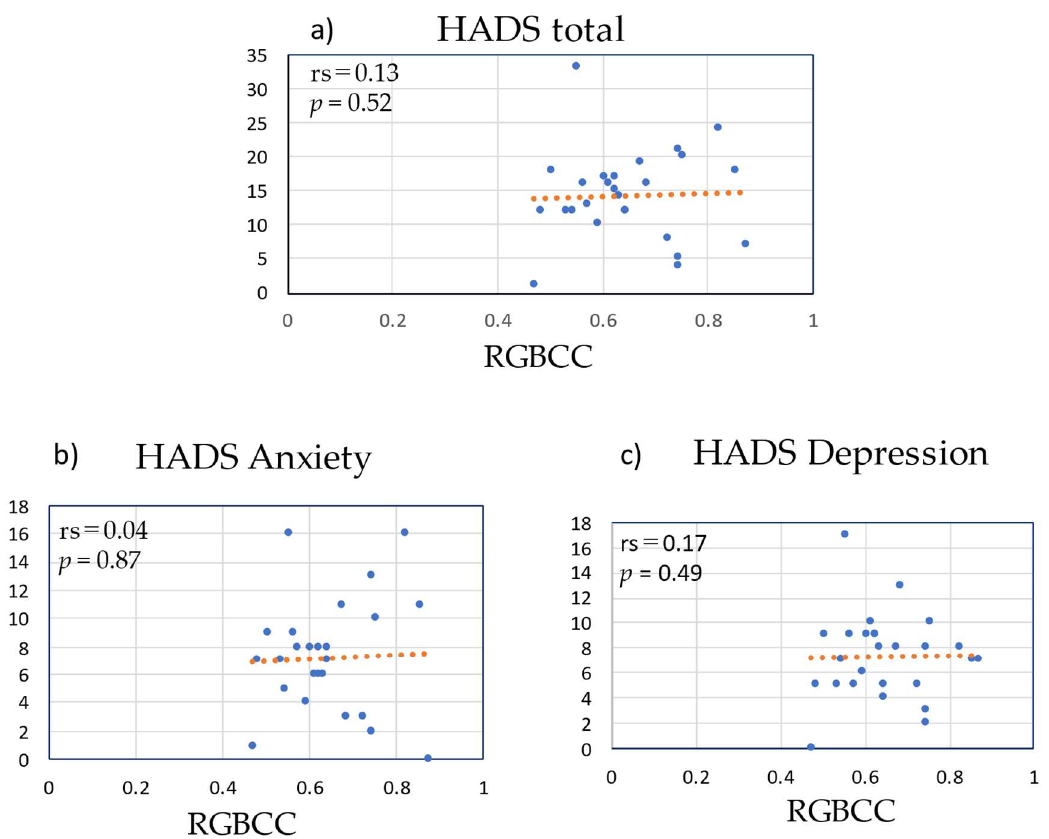
Figure 9. Correlations of red, green, and blue correlation coefficient (RGBCC) with Hospital Anxiety and Depression Scale (HADS) scores. ( a ) RGBCC versus total HADS score, ( b ) RGBCC versus score of HADS anxiety subscale, ( c ) RGBCC versus score of HADS depression subscale .